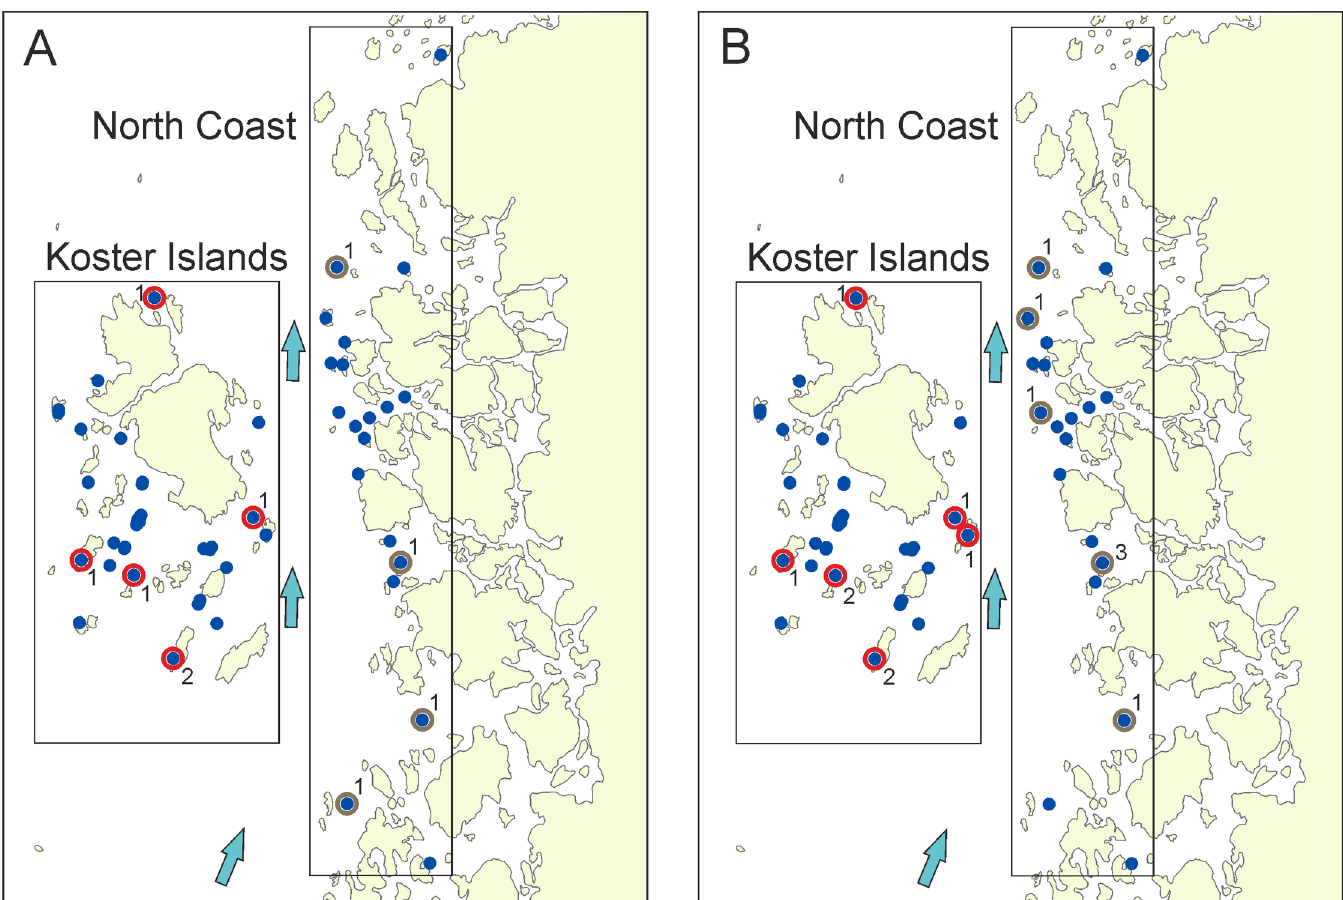
Fig 6. Distribution of all American mink samples and mink marked as migrants from the North Coast to Koster Islands (red circles) and from Koster Islands to the North Coast (brown circles). The migrants were assigned by two methods: STRUCTURE with q (cid:1) 0.8 (panel A), GeneClass2 with probability (cid:3) 0.03 (panel B). Numbers indicate the number of migrants at each location. Arrows indicate the direction of sea current. Background map: Europe Base Map — Level 1 Provinces, AND Products B.V. and AND Data Ireland Limited, ESRI.